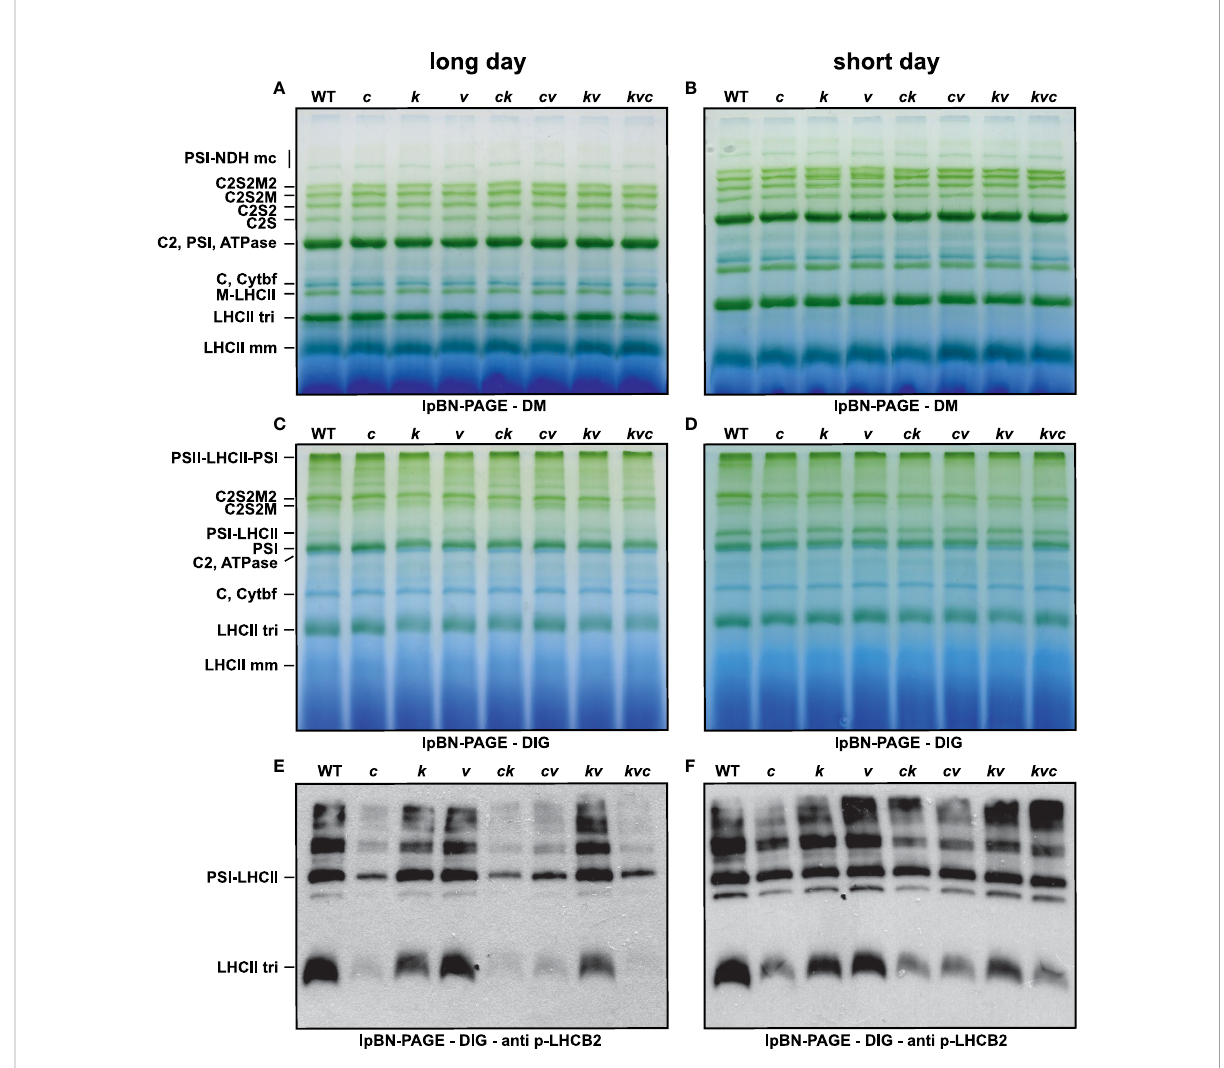
FIGURE 2 Levels of thylakoid protein complexes during long- and short-day conditions. Wild-type plants and mutants were grown using 16 h light (100 µmol photons m − 2 s − 1 )/8 h dark cycles (long day) for 3 weeks (A, C, E) or 8 h light (120 µmol photons m − 2 s − 1 )/16 h dark cycles (short day) for 5 weeks ( B, D, F ). (A, B) Large-pore blue-native gels (lpBN-PAGE) of thylakoids solubilized with 1% (w/v) n-dodecyl- b -D-maltoside (DM). (C, D) lpBN-PAGE of thylakoids solubilized with 1% (w/v) digitonin (DIG). (E, F) p-LHCB2 immunoblot from lpBN-PAGE of thylakoids solubilized with 1% (w/v) digitonin (DIG). Thylakoids were loaded on equal chlorophyll basis of 4 µg (A – D) and 1 µg (E, F) . WT – Col-0 , c – clce-2 , k – kea3-1 , v – vccn1-1 , ck – clce-2kea3-1 , cv – clce-2vccn1-1 , kv – kea3-1vccn1-1 , and kvc – kea3-1vccn1-1clce-2